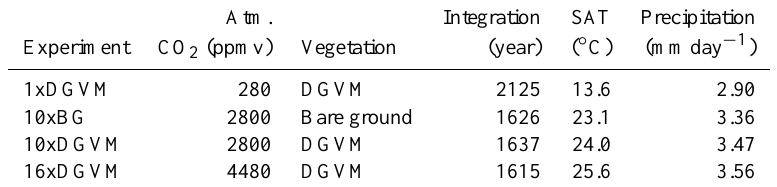
Table 2. Mid-Cretaceous CCSM3 experiments and global annual mean surface temperature (SAT) and precipitation. Atm. Integration SAT Precipitation Experiment CO 2 (ppmv) Vegetation